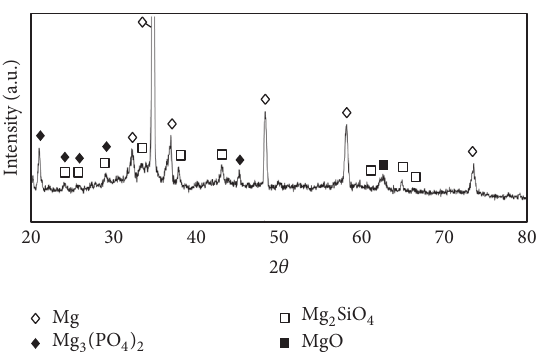
Figure 11: X-ray diffraction patterns for the sample of AZ91 magnesium alloy treated with PEO process at 0.5 A/cm 2 for 2 minutes, in an aqueous alkaline solution with 50 g/l of Na 2 SiO 3 , 40 g/l of NaOH, and 50 g/l of Na 5 P 3 O 10 .